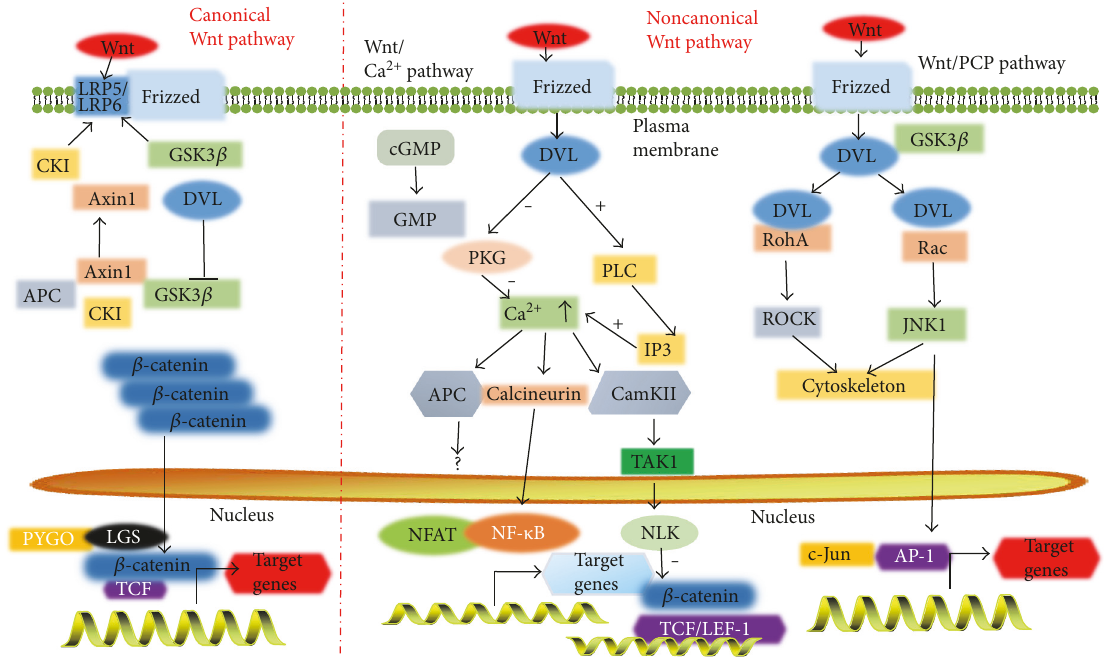
Figure 1: Illustration of Wnt signaling cascades. Based on the dependence of β -catenin, Wnt signaling can be classi fi ed as β -catenin- dependent Wnt signaling pathway (canonical Wnt signaling pathway) and β -catenin-independent Wnt signaling pathway (noncanonical Wnt signaling pathway). In canonical Wnt signaling pathway, in the absence of Wnt ligand(s), cytoplasmic β -catenin is targeted for phosphorylation by a multiprotein complex comprised of Axin, adenomatous polyposis coli (APC), glycogen synthase kinase 3 β (GSK3 β ), and casein kinase 1 α (CK1 α ). The phosphorylated form of β -catenin is recognized by an E3 ubiquitin ligase ( β -TrCP) and then targeted for proteosomal degradation, resulting in low cytosolic levels (left panel); in the presence of Wnt ligand(s), Wnt ligand binds to a FZD and LRP coreceptors, which triggers a signaling cascade by activating Dvl. The activated Dvl inhibits GSK3 β , which destroys the stability of the multiprotein complex and accordingly leads to the intracellular accumulation of cytosolic β -catenin. The stable and active β -catenin then translocates into the nucleus, in which it acts as a transcriptional coactivator with TCF/LEF to activate Wnt-responsive target genes (left panel). In a noncanonical Wnt signaling pathway, Wnt ligand (such as the Wnt5a, a typical noncanonical Wnt) binds to its receptor (FZD) and coreceptor (Ror1/2) and triggers noncanonical signaling cascades, which include the Wnt/calcium (Ca 2+ ) and Wnt/planar cell polarity (PCP) pathways. In the Wnt/Ca 2+ pathway (left panel), Wnt protein binds to FZD and Ror2 receptor and leads to activated G proteins, resulting in enhanced intracellular calcium level or decreased cGMP; the calcium/calmodulin-dependent protein kinase II (CaMKII) or protein kinase C (PKC) was then activated. In the Wnt/PCP pathway (right panel), the Wnt ligand binds to a FZD receptor on the cell surface, followed by activating Rho/Rac small GTPase and Jun N-terminal kinase (JNK) to assist with cytoskeletal organization and gene expression (right